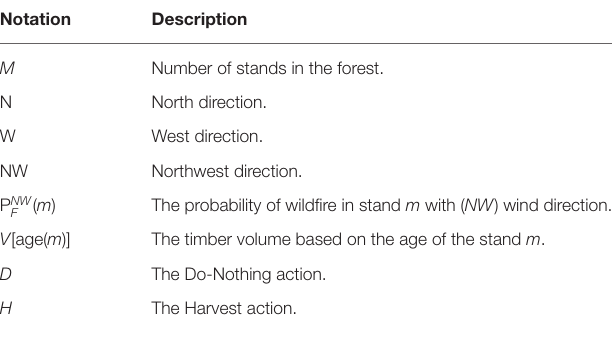
TABLE 1 | List of notation for wildfire occurrence